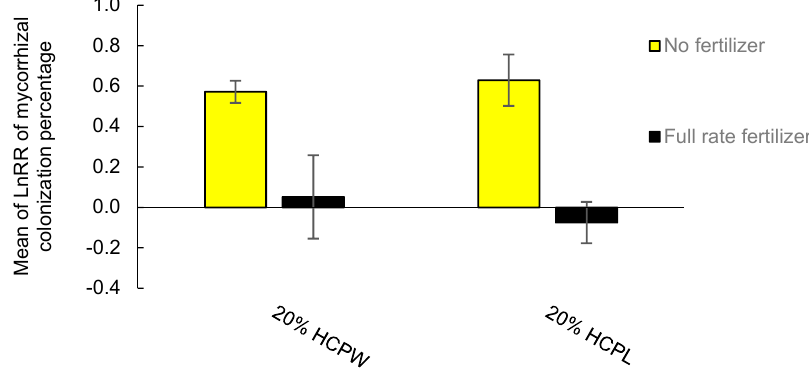
Figure 5. Mean ( ± 95 CI, n = 3) natural logarithmic response ratios (standardized with the untreated fully-fertilized control) of mycorrhizal colonization percentage of pine tree seedlings grown in peat mixed with 20% (v / v) hydrochar powder (HCPW) and hydrochar pellet (HCPL) in unfertilized (yellow bars) and full fertilized (black bars) regimes. E ff ects of hydrochar type and application rate were considered significant, relative to controls receiving 100% fertilizer, when 95% CI did not overlap with zero in each nutritional regime.